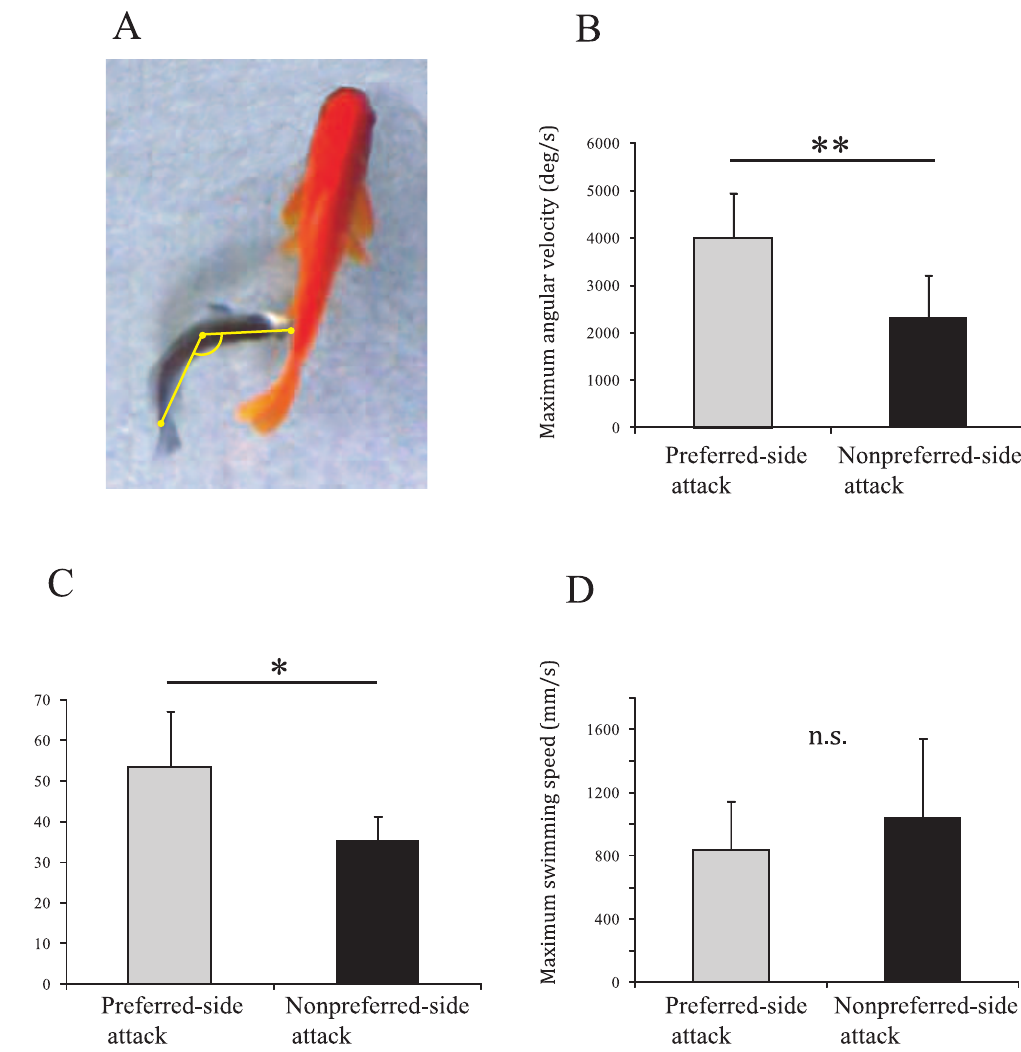
Figure 4. Kinematic differences in scale-eating behavior between preferred- and nonpreferred-side attacks. (A) The body flexion angle of scale-eating behavior was measured from three points on the body midline. (B) Maximum angular velocity (mean 6 SD) of preferred-side (N=39) and nonpreferred-side attacks (N=4). (C) Body flexion amplitude. (D) Maximum swimming speed during the approach. P-values were obtained by means of the Wilcoxon signed-rank test. *p , 0.05, **p , 0.01, n.s., not